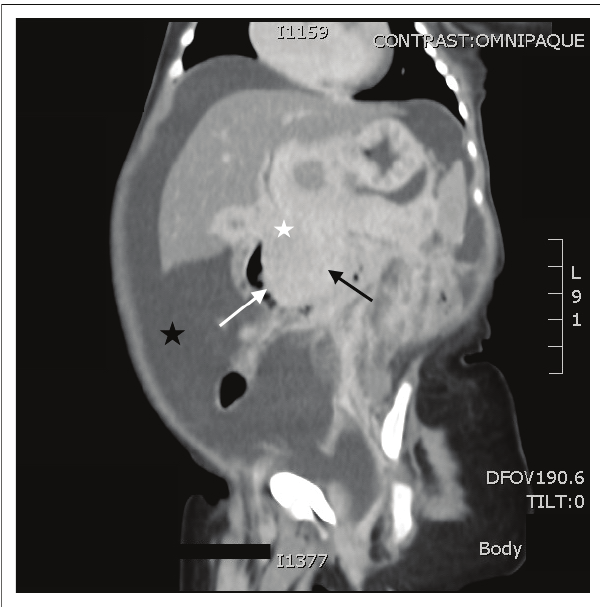
FIGURE 3: Axial post-contrast computed tomography image demonstrating the locally invasive pancreatic mass (black arrow) with a poor plane of separation from the D2 segment of the duodenum (white